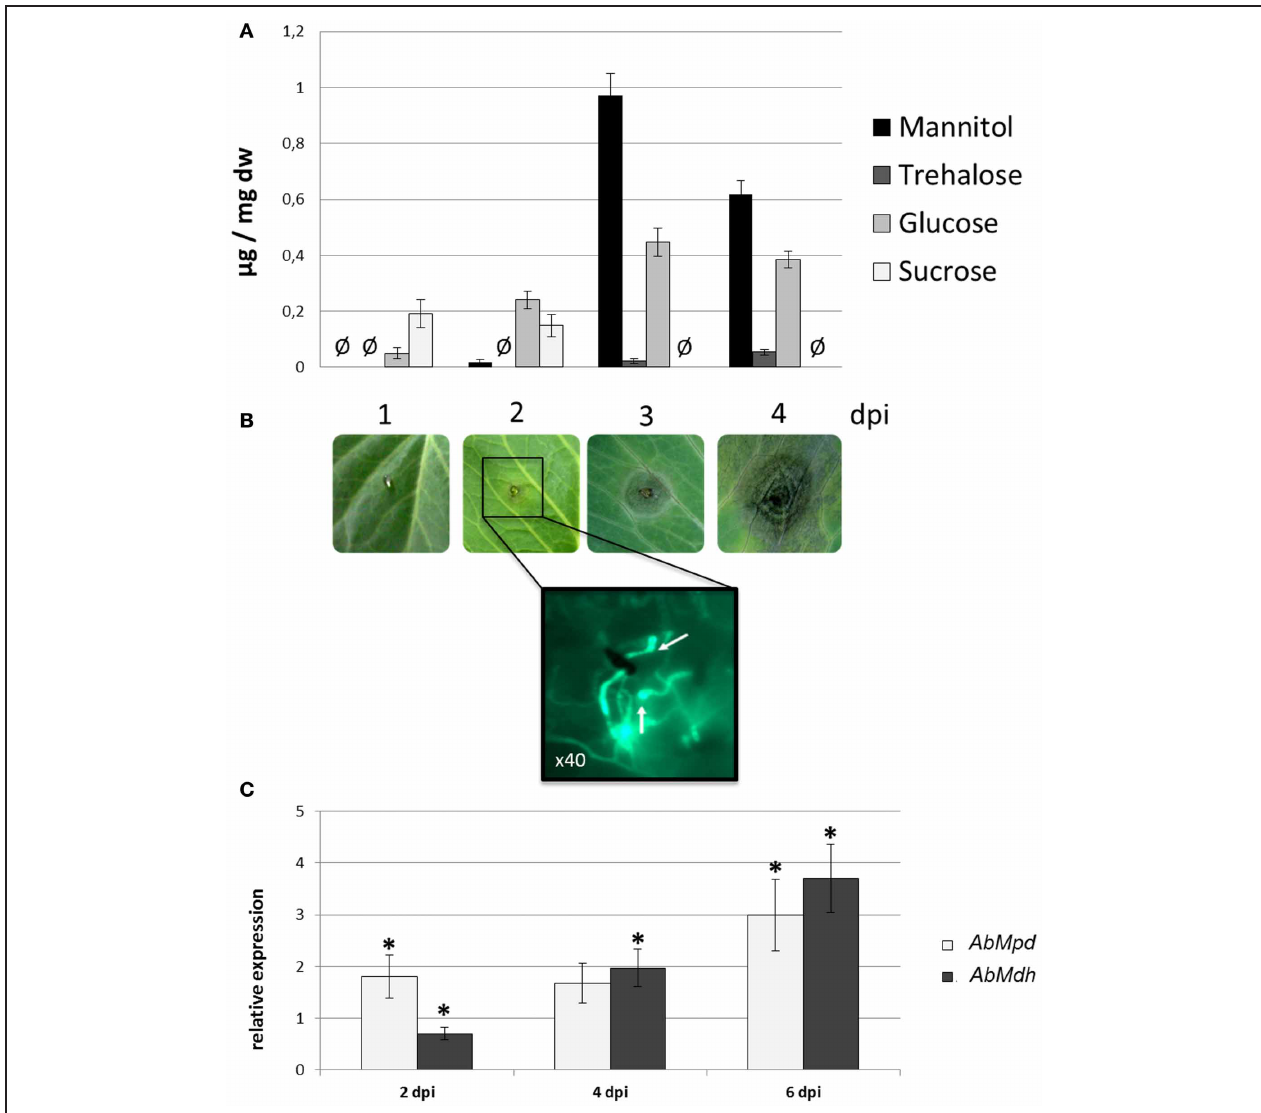
FIGURE 8 | Mannitol metabolism during plant colonization. (A) Major soluble carbohydrate concentrations (expressed in μ g/mg DF) measured by HPLC during the infection kinetics of the A. brassicicola wild-type strain on Brassica oleracea . Undetected sugars are represented by the symbol Ø. Three independent experiments were done. (B) Progression of symptoms on a B. oleracea leaf inoculated with the Abra43 strain and microscopic observations of the infection structures at 2dpi. Inoculated plant tissue fragments were collected at 2dpi and stained with solophenyl flavine for fluorescence microscopy observations. Appressoria-like structures are indicated by white arrows. (C) Quantitative